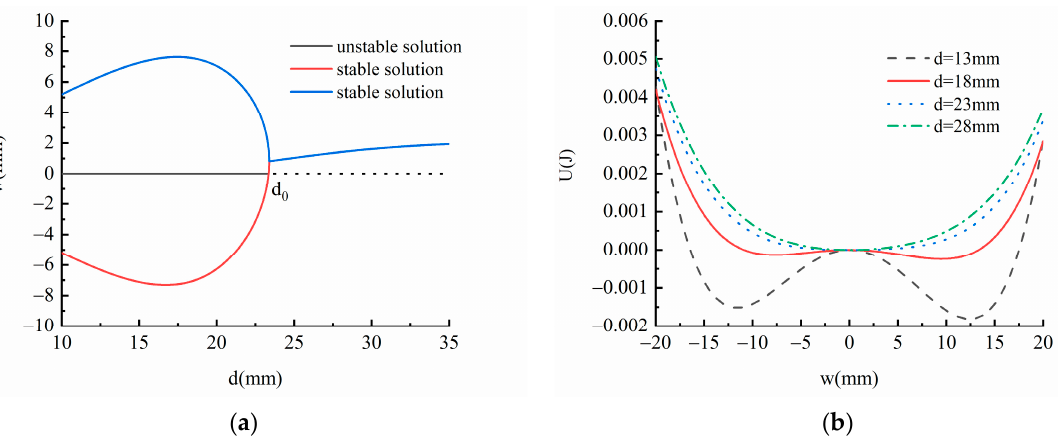
Figure 4. ( a ) static bifurcation of the system; ( b ) potential energy diagram of the system at different magnet spacing.